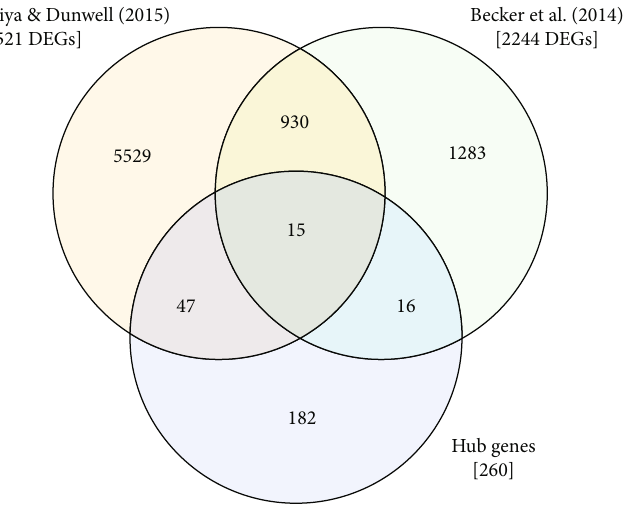
FC j ≥ 2 : 0 and p value < 0.05) obtained from E-MTAB- 2